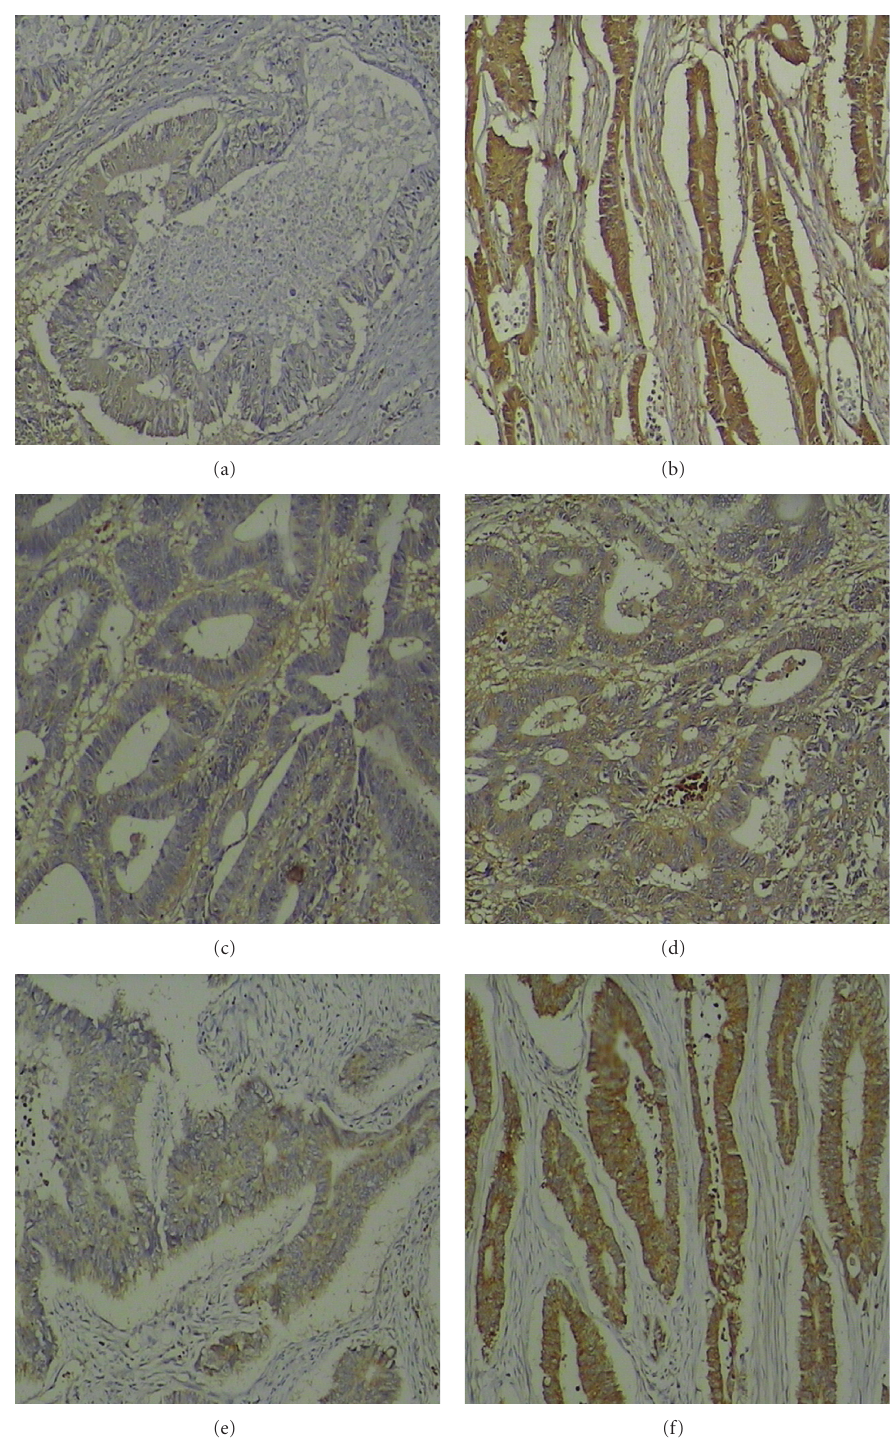
Figure 1: Expression of HIF-1 α , CXCR4, and VEGF in colon primary tumor samples. Sections were subjected to routine depara ffi nization and rehydration. Antigen retrieval was achieved by microwaving in citrate bu ff er for 10min. The endogenous peroxidase activity was inhibited by incubation with 3% hydrogen peroxide. The specimens were reacted overnight with anti-HIF-1 α antibodies, anti-CXCR4 antibodies, and anti-VEGF antibodies, then were incubated with rat anti-mouse-IgG2b-horseradish peroxidase. The sections were then counterstained with hematoxylin and mounted (see Section 2). HIF-1 α staining was observed in the cytoplasm and in the nucleus of the tumor cells, CXCR4, and VEGF staining was observed in the cytoplasm of tumor cells. Positive staining was observed as a brown color. Weakly positive immunohistochemical staining of three molecules in (a) (HIF-1 α ), (c) (CXCR4), (e) (VEGF), respectively ( × 100). Strongly positive immunohistochemical staining of three molecules in (b) (HIF-1 α ), (d) (CXCR4), (f) (VEGF), respectively, ( ×